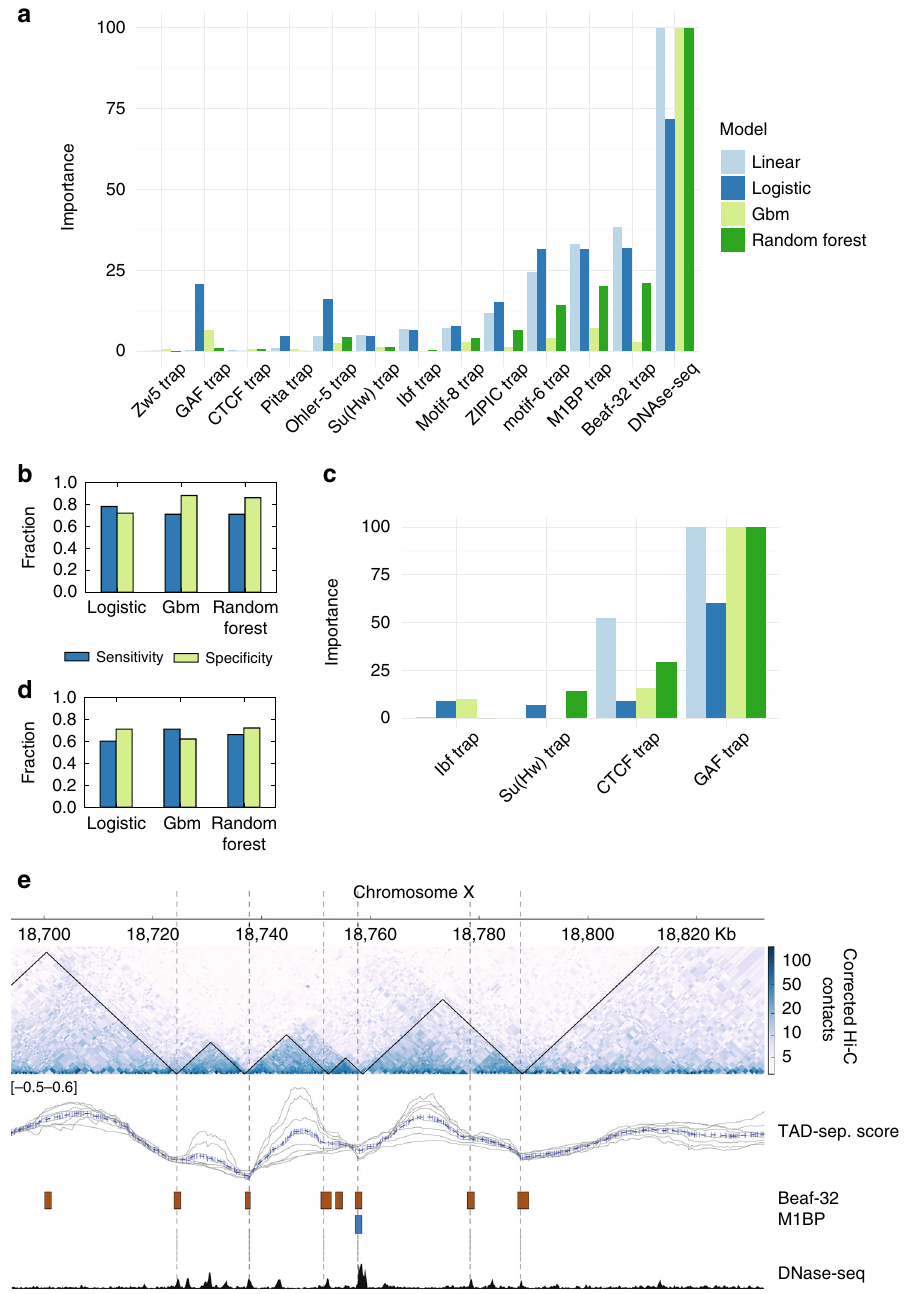
Fig. 5 Prediction of boundaries using machine learning. a Feature importance for promoter boundaries computed using four different methods: linear model, logistic regression, gradient boost model (gbm), and random forest. Importance scores of each method were scaled from 0 to 100. Except for DNAse-seq, each feature represents the binding af fi nity (TRAP score) of the respective motif. b Sensitivity and speci fi city for promoter boundaries measured for logistic regression, gradient boost model and random forest. The output of the linear model can be seen in Supplementary Figure 5b. c Feature rankings, as in a , for non-promoter boundaries. d Sensitivity and speci fi city for non-promoter boundaries. e Examples of high-resolution boundaries and predicted boundaries. The high-resolution boundaries (based on the TAD-separation score) are depicted as black triangles on top of the Hi-C heatmap. The predicted boundaries are shown as dotted vertical lines. The tracks below the Hi-C contact map contain the instances of the motifs that overlap with promoters. To aid the visualization of the short motifs, their genomic location was extended by 500 bp in each direction. The last track depicts regions of open chromatin based on DNase-seq from modEncode